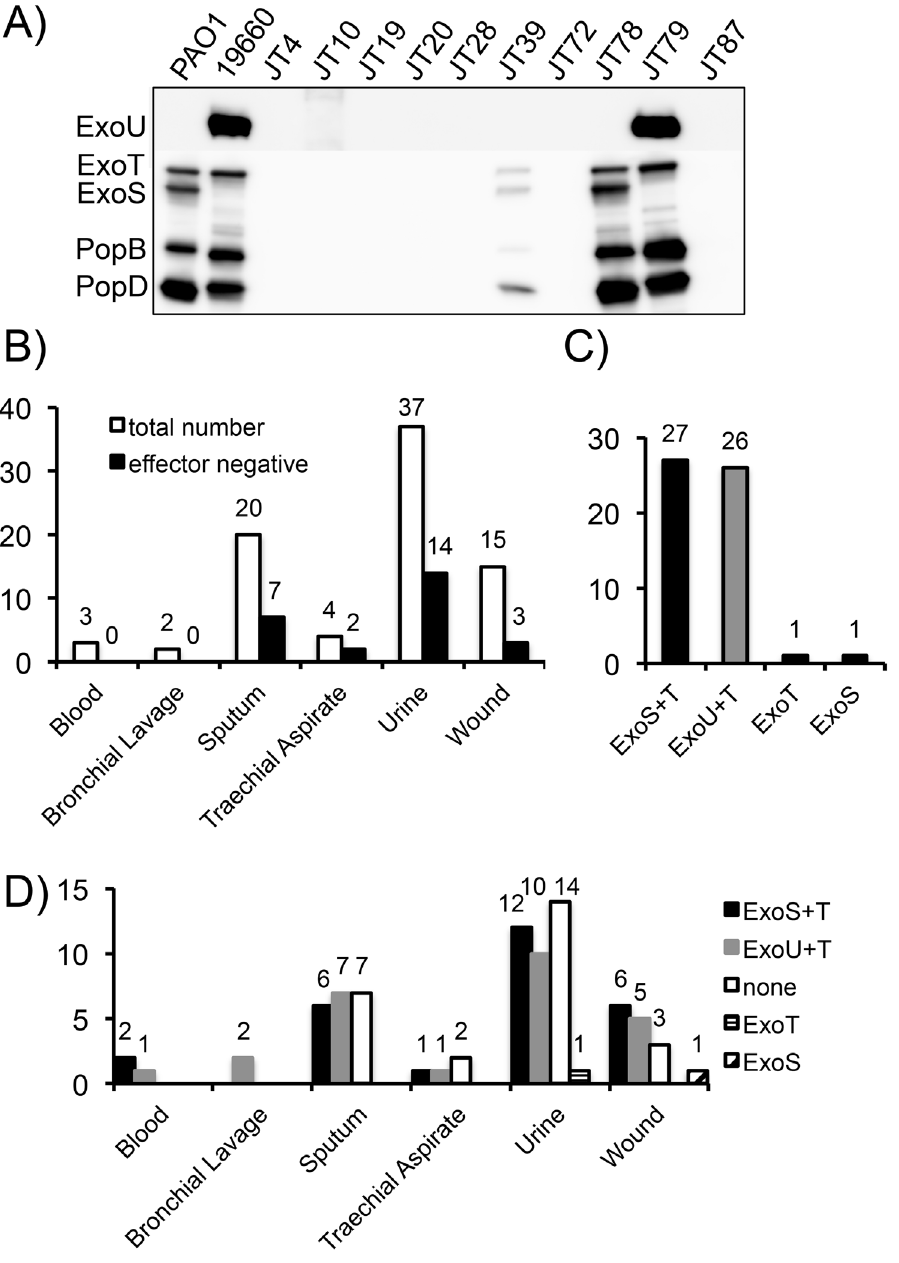
Figure 1. Effector expression by clinical P.aeruginosa isolates. A) A representative western blot showing effector (ExoS, ExoT and ExoU) as well as translocator (PopB and PopD) production in clinical isolates of P. aeruginosa . Protein supernatants were isolated from the indicated P. aeruginosa strain under T3SS inducing conditions (low calcium) and concentrated by precipitation with trichloroacetic acid before separating the proteins by SDS-PAGE and probing for the presence of the indicated effector and translocator proteins by western blot. B) Distribution of T3SS effector-positive and negative bacteria by site of isolation. C) Total distribution of produced effectors by T3SS effector-positive strains. D) Distribution of effectors produced by site from which the strains were